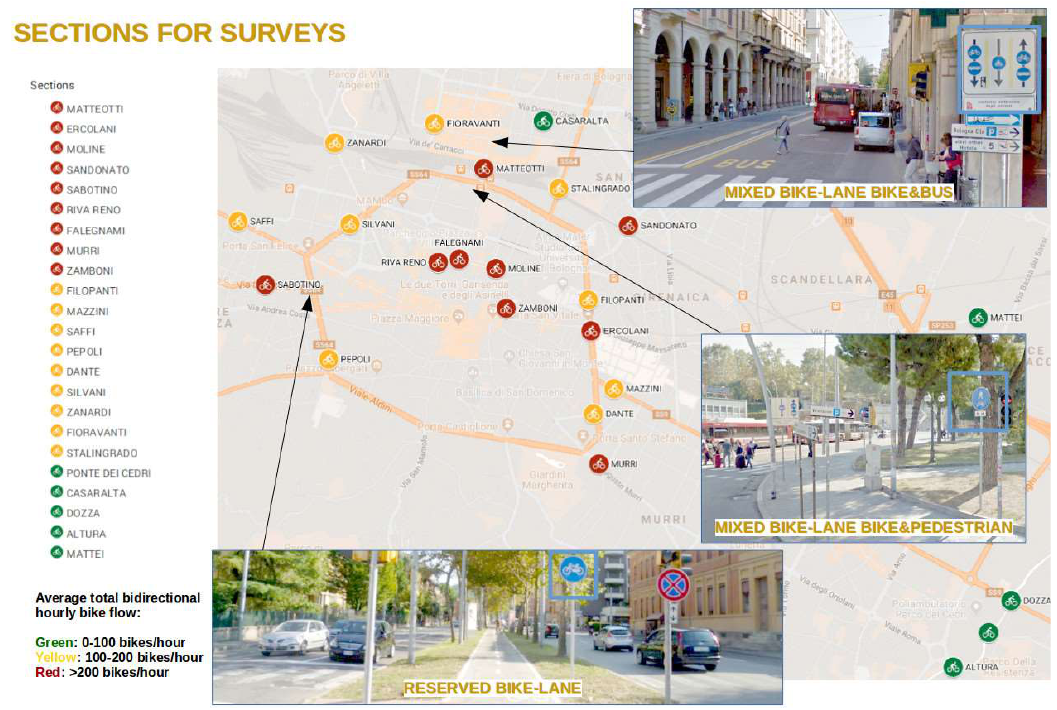
Figure 3. Road sections monitored in 2018—Legend shows sections sorted by flow value.